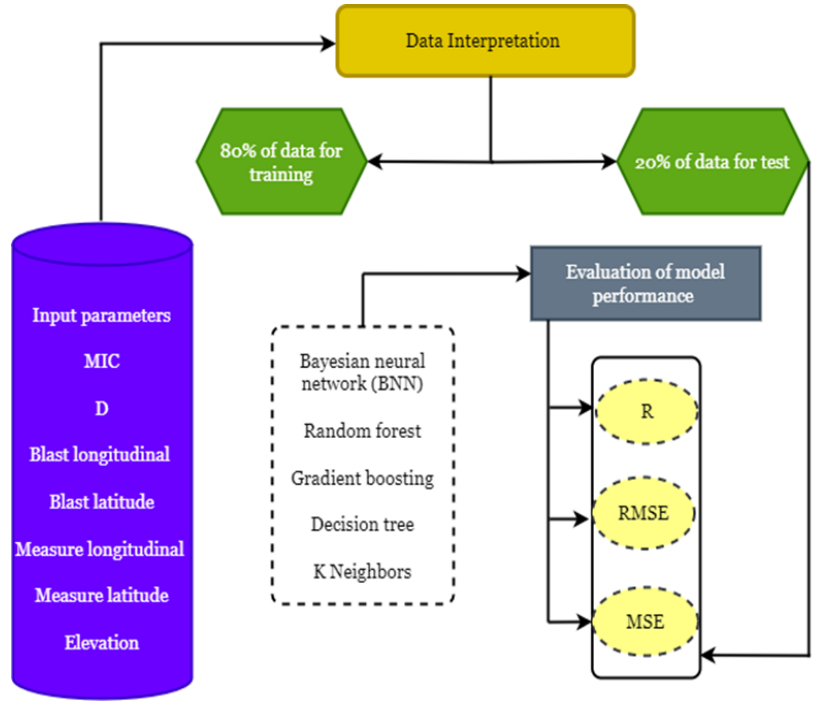
Figure 1. Flow chart of the overall analysis of the study, with model execution and prediction of